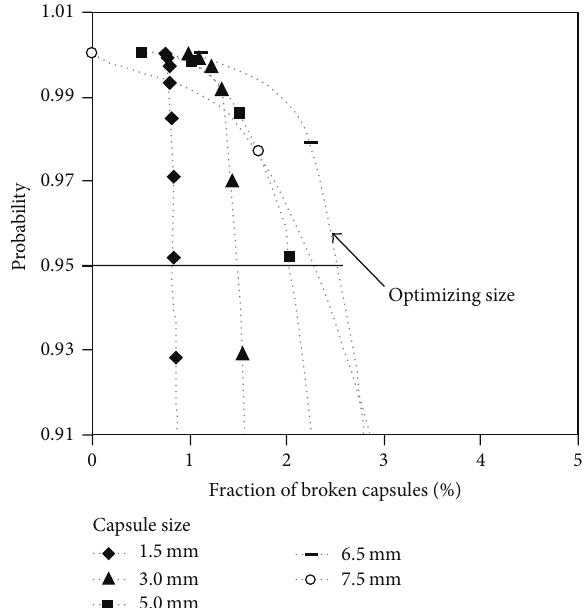
Figure 9: Probability of a crack hitting capsules with different size (volume fraction of capsules mixed: 5%).